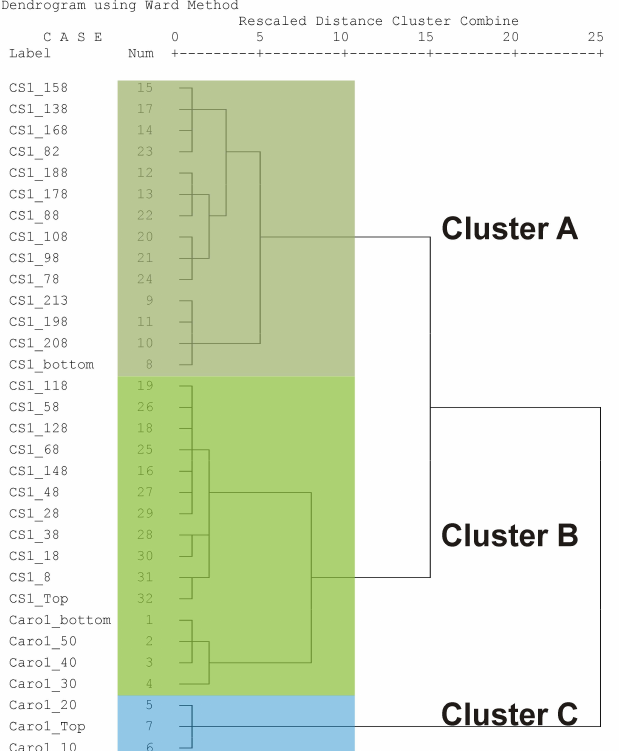
Figure 6. Dendrogram of Q-mode hierarchical cluster analysis of the samples, based on the relative abundance of species >5% (Cluster A: A. mamilla assemblage; Cluster B: A. mamilla and L. lobatula assemblage; Cluster C: C. carinata assemblage).